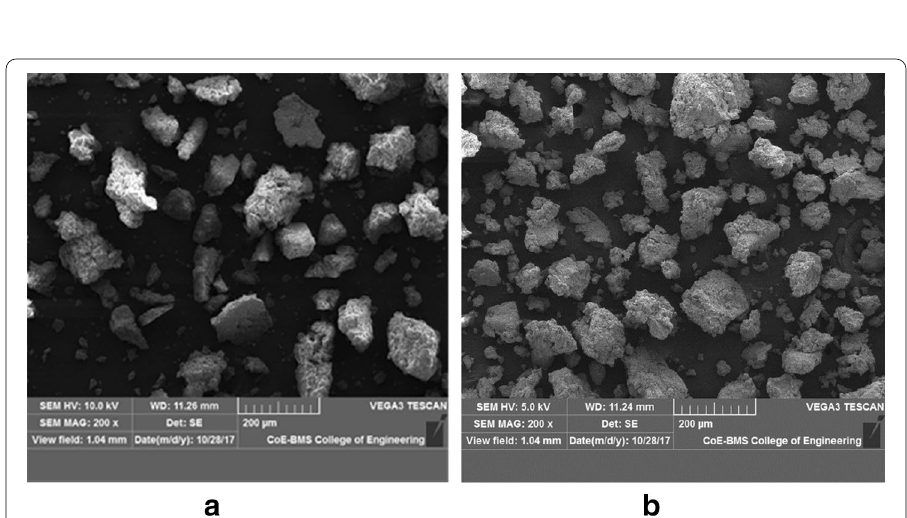
Fig. 11 Scanning Electronic Micrographs images (300